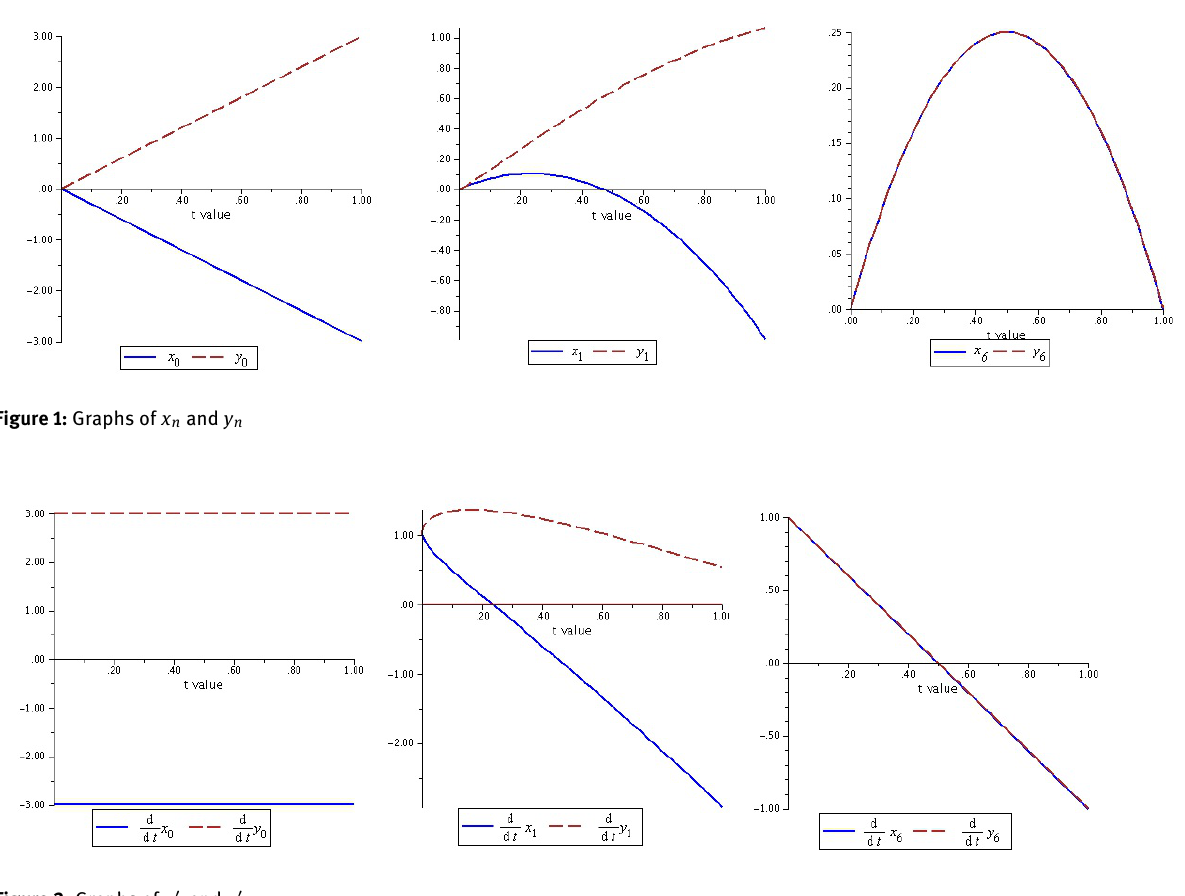
Figure 2: Graphs of x (cid:48) n and y (cid:48)